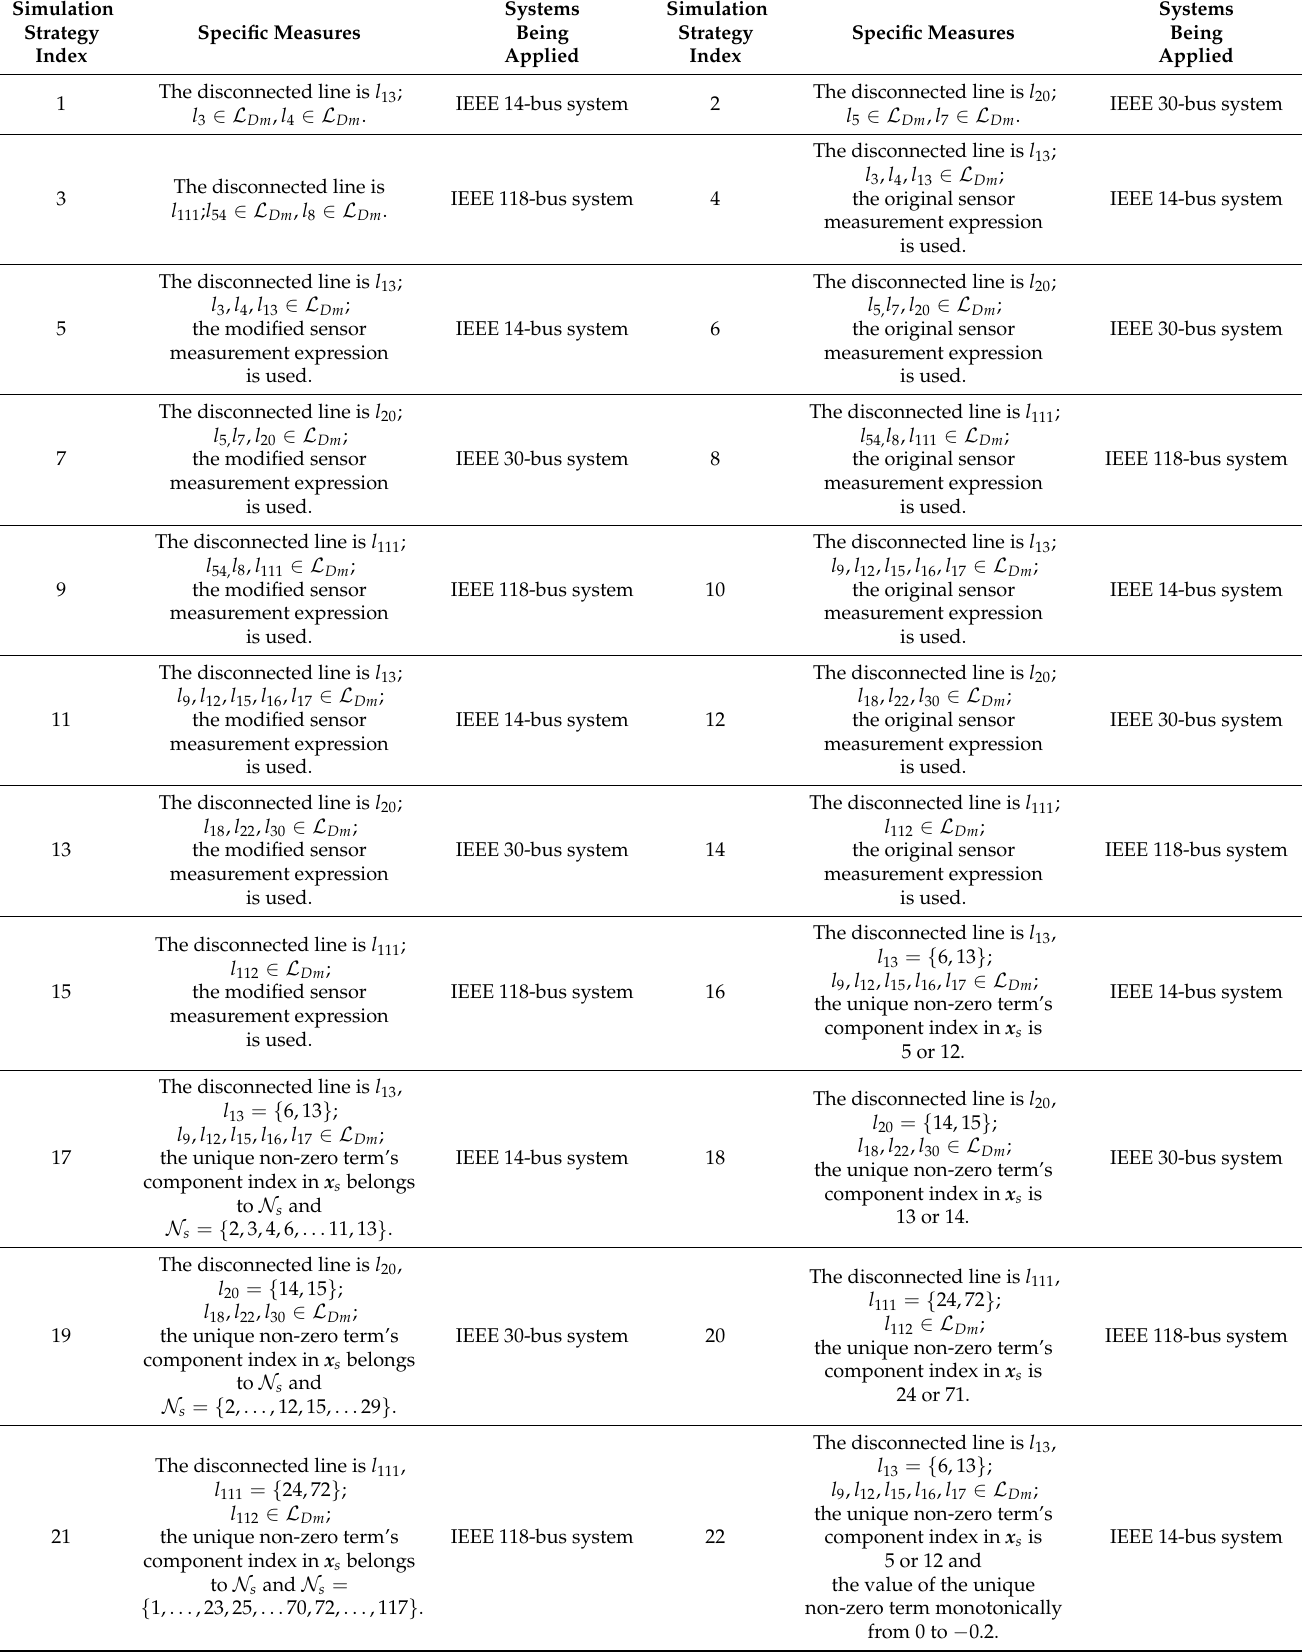
Table 2. Specific measures and the systems to which they were